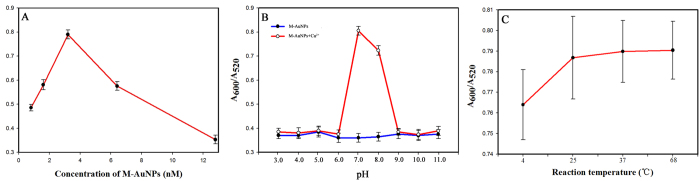
Effect of the concentration of the M–AuNPs (A), the pH value (B) and the reaction temperature (C) on the signal response of the colourimetric assay. The absorbance ratio value (A600/A520) were obtained by UV–vis spectrophotometry. Cu2+ concentration was 4 μM. Error bar at n = 3.